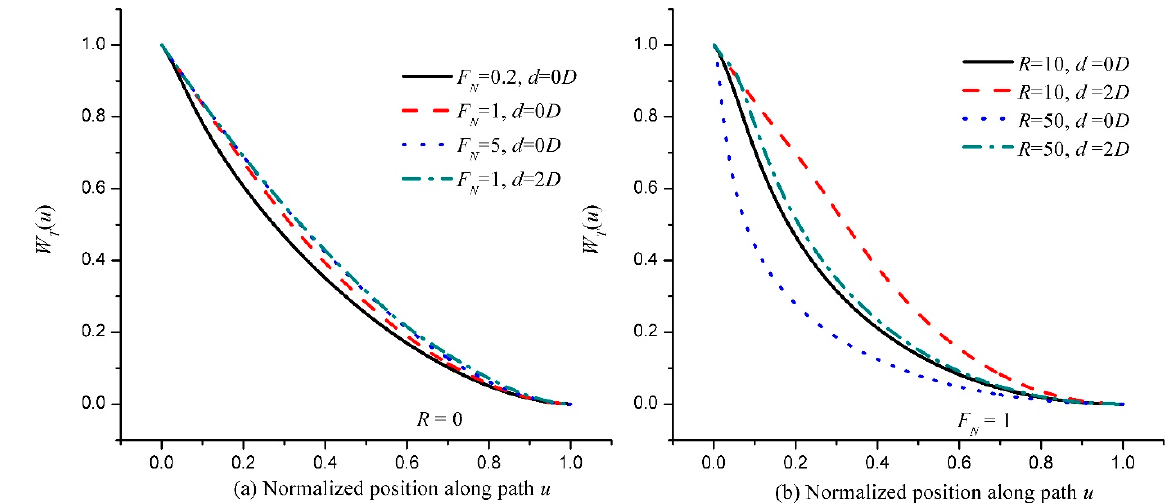
Figure 4. Normalized path-weighting function W T ( u ) for spherical waves. ( a ) Point sources with various F N ( F N = D 2 / λ L ) and d (the distance between aperture centers) values. ( b ) Distributed sources with various R ( R = D S L/DL S ) and d values when F N = 1.